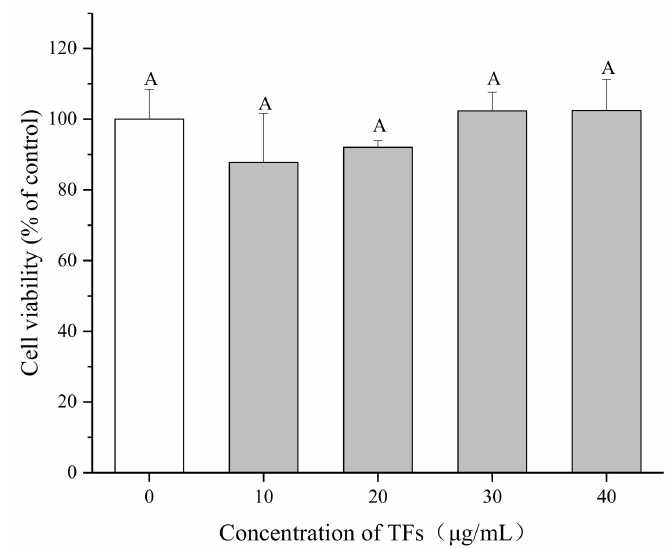
Figure 2. Effect of theaflavins (TFs) on HepG2 cell growth at 24 h. Cell viability was determined by MTT assay. Data are represented as means ± SD from five replicates. Significant differences between different treatments are showed by different letters ( p <